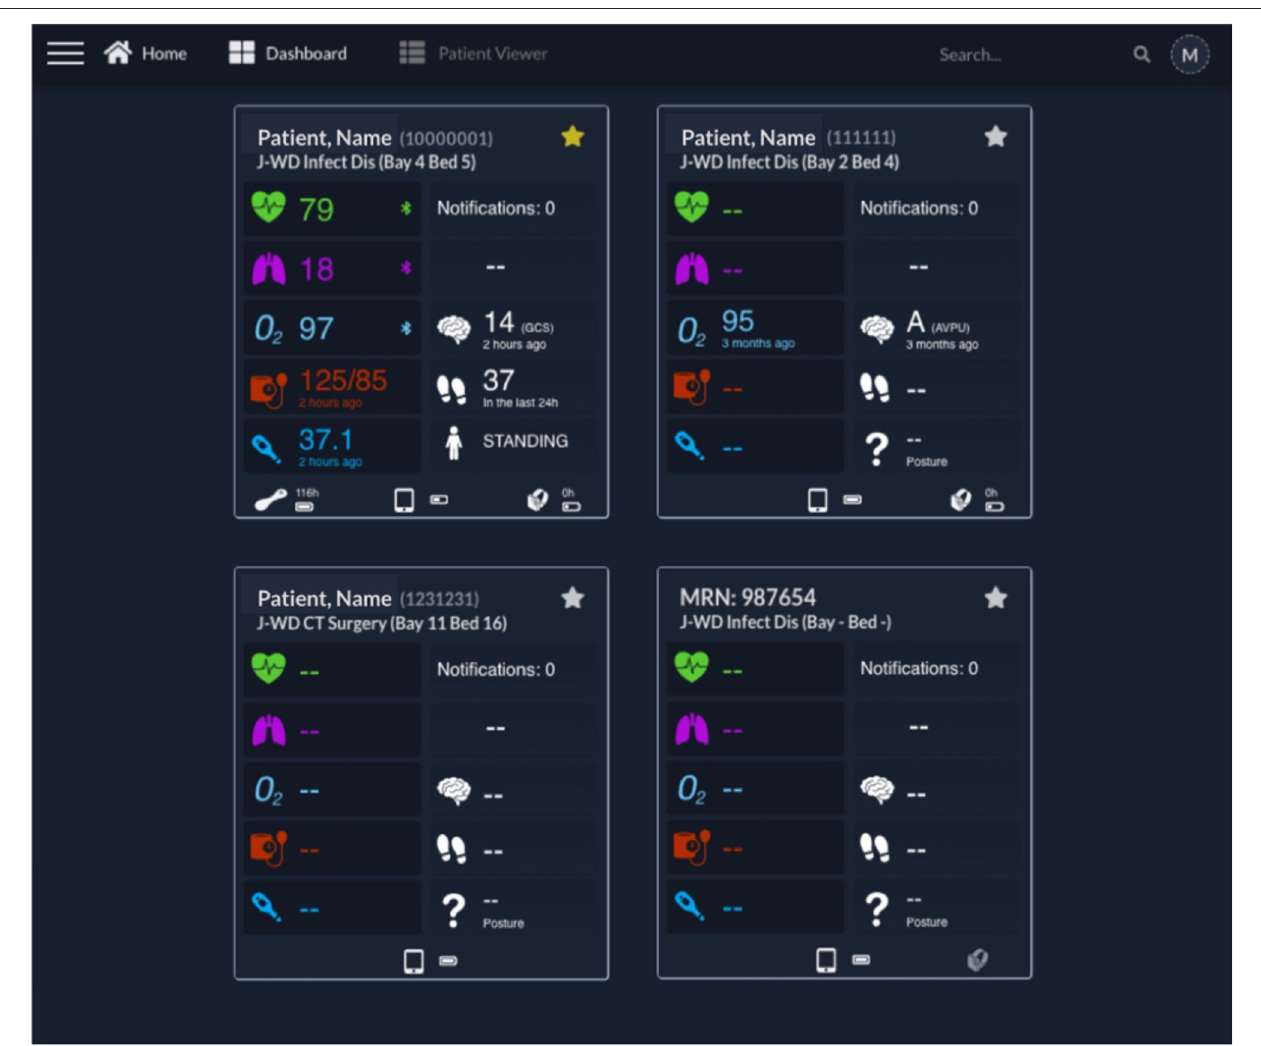
FIGURE 4 | Clinician Dashboard homepage with four exemplar test patient cards. Each card presents on the left: the Heart Rate, Respiratory Rate, peripheral blood Oxygen Saturation (“O 2 ”), Blood Pressure, and Temperature; and on the right: the Notifications (disabled at this time), continuous Early Warning Score (disabled at this time), Level of consciousness, Steps and Posture. The patient name, Medical Record Number and location are shown at the top of each card. At the bottom of each card, the status of the wearables, including connectivity and battery status, can be observed (from left to right, the VitalPatch ® , tablet, and Nonin icons are shown when present—such as in the first card). It can be noted that the upper left patient is “Starred” (by the active yellow star), with a VitalPatch ® device connected, in range and with a remaining battery of 118h; the tablet has a battery charged at 50% of capacity; and the Nonin device is connected to the tablet but has no battery left (0h). The battery icon flashes in this case, to prompt for a change of batteries. The upper right patient had their last observation 3 months ago, showcasing the system’s ability to keep the last patient state until they are discharged from the system (the Nonin also has no battery left in this case). The lower left patient has been pre-registered but the wearable devices have not yet been attached to the patient, as indicated by the lack of icons for the wearables, and thus no vital-sign data are available yet. The lower right patient has no “Patient, Name,” being identified only by the MRN in this case. The right-side Nonin icon is also greyed, representative of a Nonin pulse oximeter associated with the patient but out of range from the patient’s assigned vHDU tablet. AVPU, Alert, Voice, Pain, Unresponsive scale; GCS, Glasgow Coma Scale; J-WD, John Radcliffe Hospital Ward Code; MRN, Medical Record